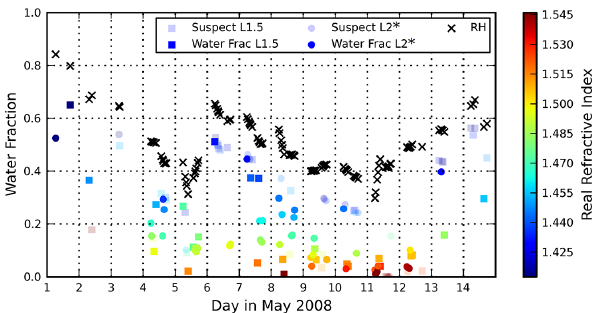
Figure 11. Calculated water volume fraction, optimized real refrac- tive index (RRI, color-filled squares for L1.5 and dots for L2*) and columnar relative humidity (RH). Results from suspect AERONET data are opaque.